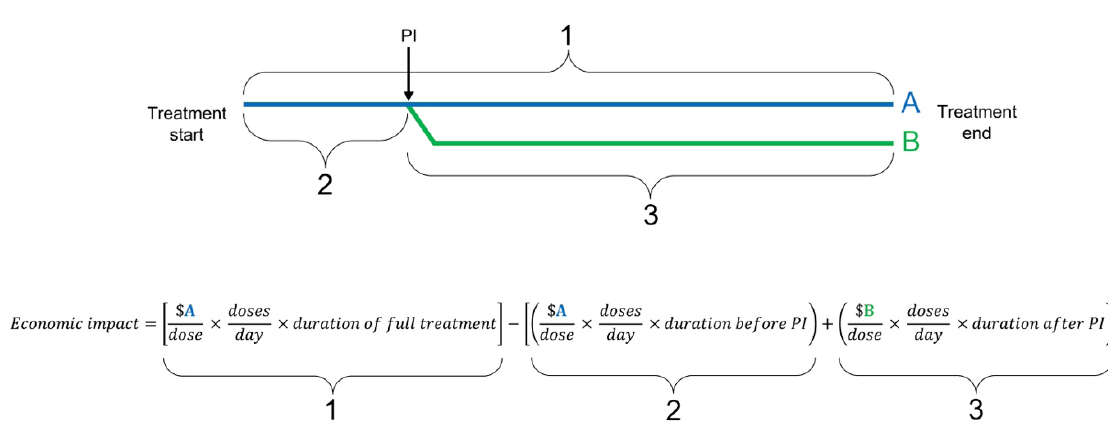
FIGURE 2 - Treatment timeline and the equation used to calculate the economic impact of a pharmaceutical intervention. Letters A and B are the different treatments and the numbers 1, 2 and 3 are the period costs. Letter A is the treatment without PI and letter B is the treatment after PI. Number 1 represents the period cost of the full treatment without PI, number 2 is the period cost before PI and the number 3 is the period cost after PI (adapted from Saokaew, Maphanta, Thangsomboon,